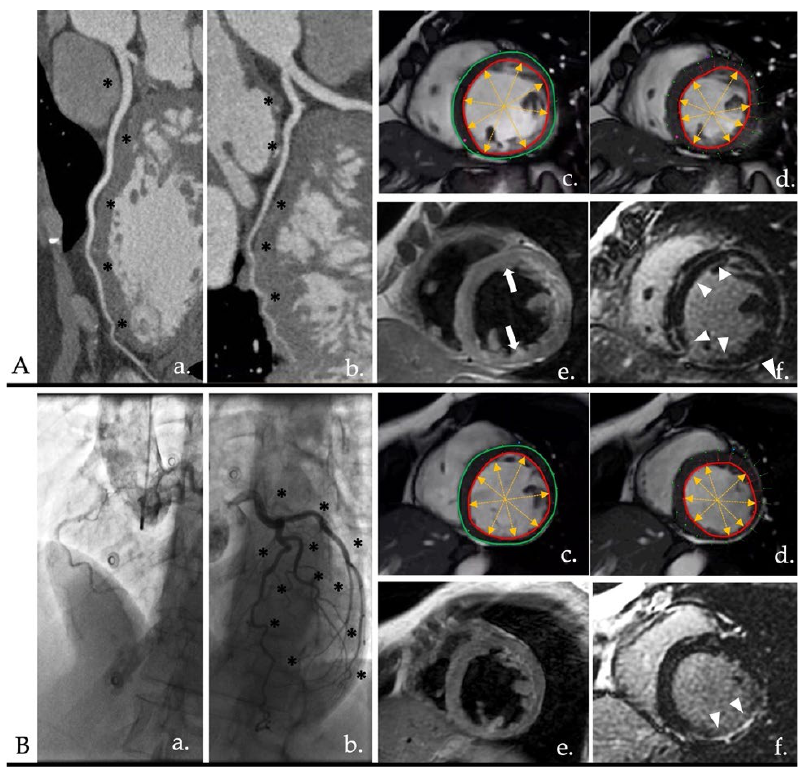
Figure 4. Panels ( A , B ) show the comparison of two patients with left ventricular dilatation and HFrEF. In images ( a , b ), anatomic evaluation of the coronary tree shows NOCAD (black asterisks). In images ( c , d ), cine images of the diastolic and systolic phase are shown, respectively. In both cases, the inferolateral wall appears to be thin. In panel ( B ) is evident a segmental akinesia compared to panel ( A ) which shows different areas of akinesia with a non-territorial distribution. Moreover, areas of fatty replacement could be highlighted in case ( A ) (image ( e ), white arrows), compared to case ( B ). Image ( f ) shows the LGE. Panel ( A ) shows a subepicardial and mesocardial LGE (non-ischemic pattern) with a ring-like distribution (>3 contiguous segment; white arrowheads). Panel ( B ) shows a subendocardial-to-transmural LGE (ischemic pattern). Panel ( A ) shows a case of DSP cardiomyopathy, while panel ( B ) shows a MINOCA-like syndrome. HFrEF: heart failure with reduced ejection fraction; NOCAD: non-obstructive coronary artery disease; LGE: late gadolinium enhancement; DSP: desmoplakin; MINOCA: myocardial infarction with non-obstructive coronary arteries.